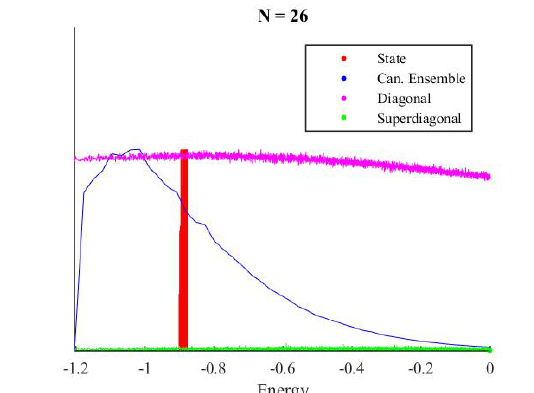
Figure 13 . The diagonal (magenta) matrix elements of f 1 (0) ; ( t (cid:3) ) g 2 , where t (cid:3) is the scrambling time, vary slowly in the SYK model. They, moreover, dominate the elements just above the diag- onal (green). The regions important for the typical state (red) and the canonical ensemble (blue, (cid:26) ( E ) e (cid:0) (cid:12)E ) are shown as well. The operators were not passed through a low pass